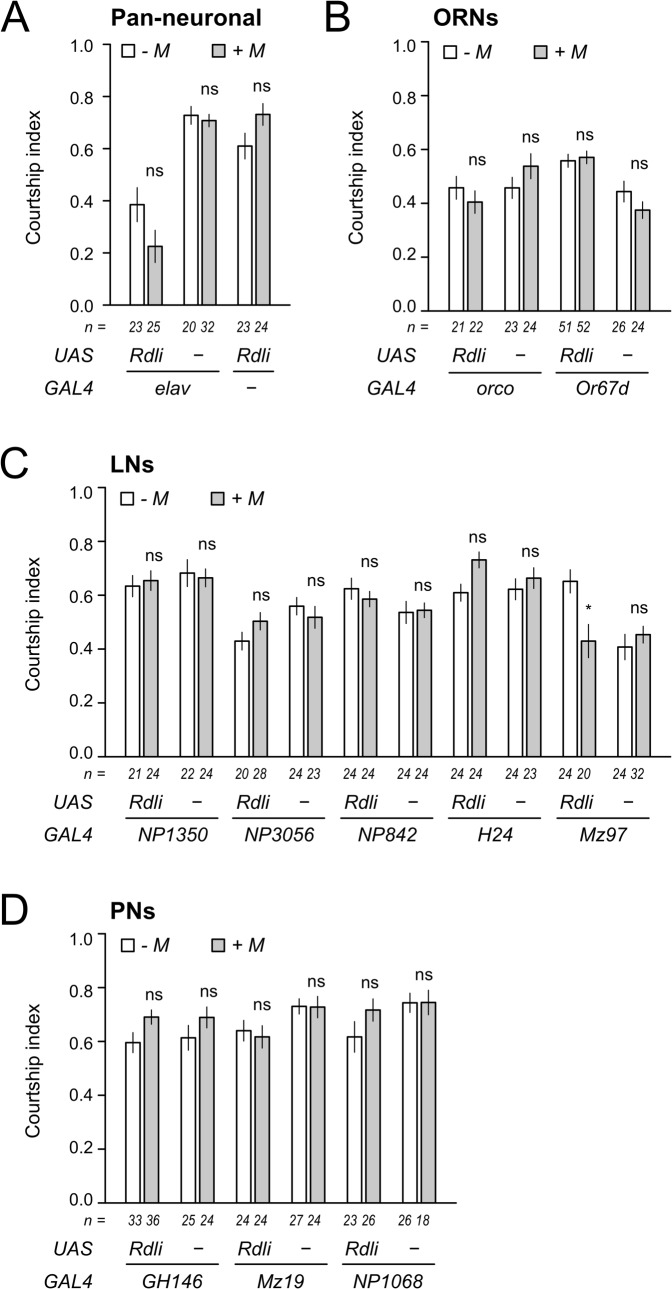
The GABAA receptor in LNs is involved in the behavioral habituation to cVA.The defect of behavioral habituation to cVA was analyzed by interference of the expression of GABAA receptors in a major class of olfactory neurons using pan-neuronal (A), ORNs (B), LNs (C), and PNs (D) drivers. The male flies were all trained with the male odor for 60 minutes, and then courtship responses to the females without (- M) or with (+ M) male odor in the lower cell of the chamber were measured (see Fig 1A). Bars indicate mean ±SEM. *, P < 0.05; ns, not significant from the Student's t-test with Holm's correction.